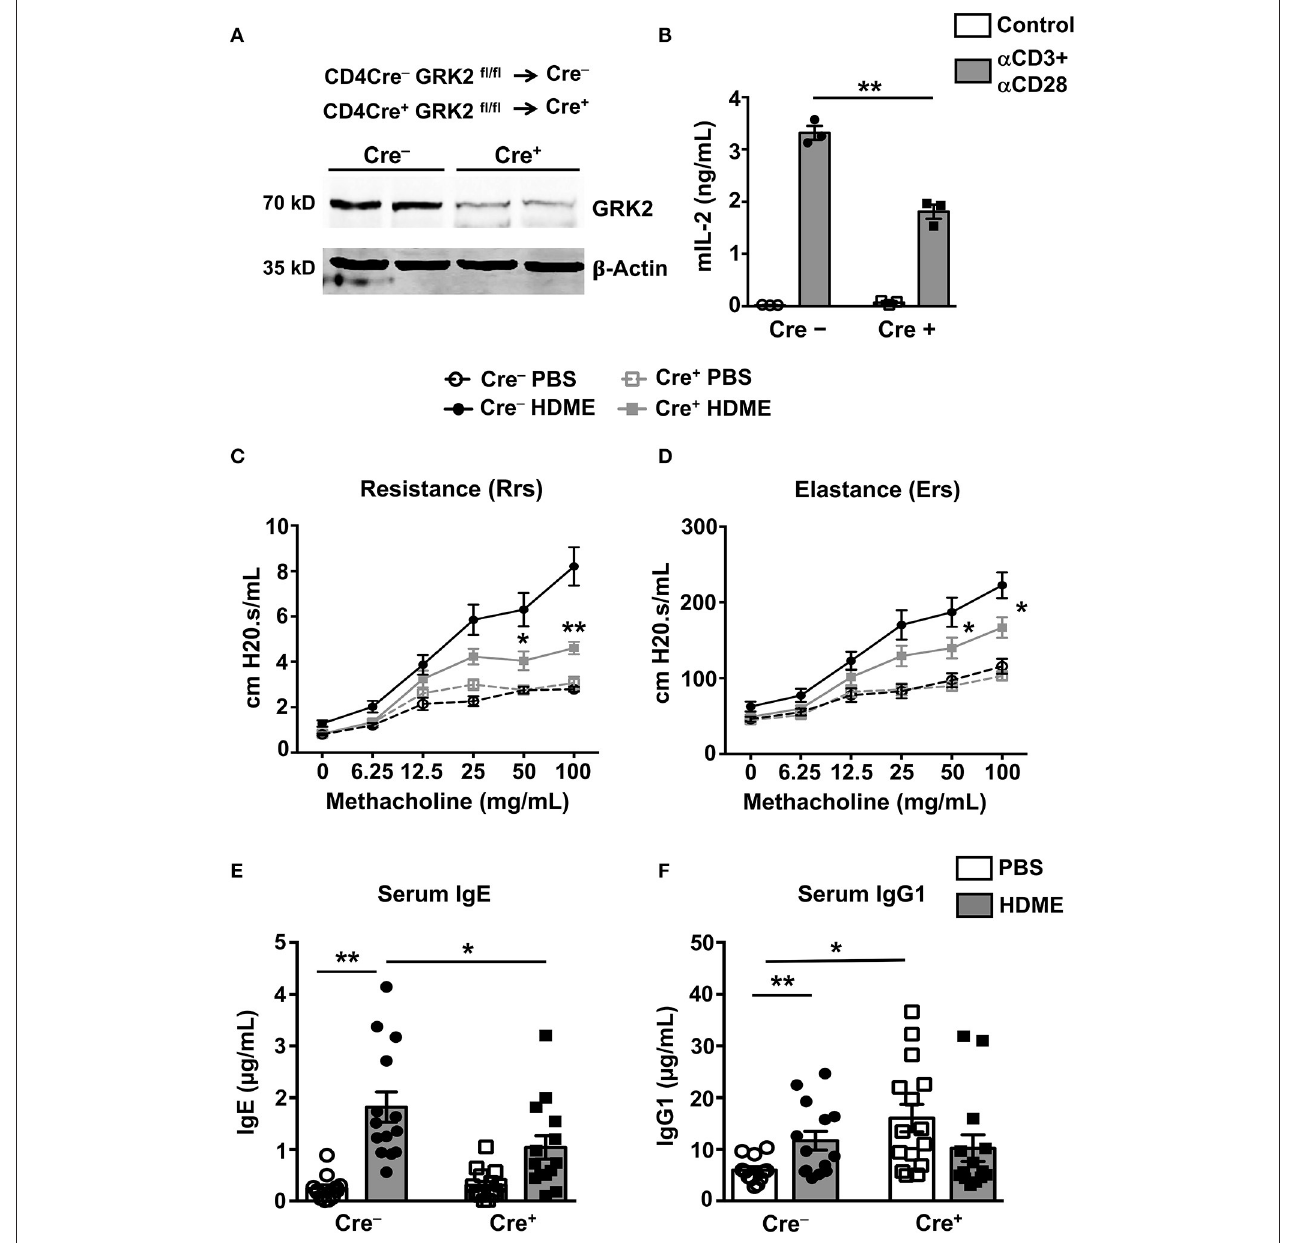
FIGURE 4 | Mice lacking GRK2 specifically in T cells show attenuated AHR and serum IgE levels following HDME challenge. (A) CD4T cells were purified from splenocytes of Cre − and Cre + mice and western blotting was performed to determine GRK2 levels in CD4T cells. A representative blot with samples from two mice per group is shown. (B) CD4T cells isolated from Cre − and Cre + mice were stimulated with plate bound anti-CD3 (10 µ g/ml) and anti-CD28 antibodies (5 µ g/ml) for 72h and the supernatants were analyzed for IL-2 production by ELISA. (C,D) PBS control or HDME-exposed Cre − and Cre + mice were anesthetized 24h after the last HDME challenge and analyzed for AHR. (C) Rrs and (D) Ers values after challenge with increasing doses of methacholine are shown. Statistical significance for the AHR experiments was determined by two-way ANNOVA with Bonferroni’s correction. * p ≤ 0.05, ** p ≤ 0.01. (E,F) Bar graphs show levels of (E) serum IgE and (F) serum IgG1 in Cre − and Cre + mice treated with PBS or challenged with HMDE. Data are presented as mean ± SEM and are pooled from 2 to 3 independent experiments with a total of 6–15 mice per cohort. Both male and female mice were used for the HDME experiments. Statistical significance was determined Student’s unpaired t -test. * p ≤ 0.05, ** p ≤